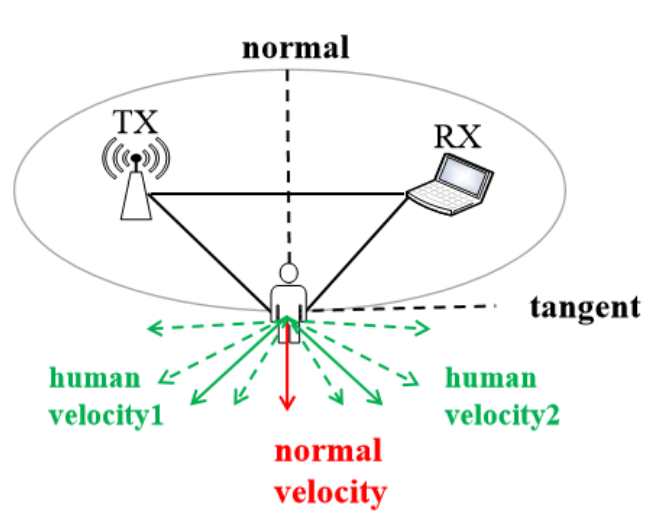
Figure 7. Directional ambiguity on symmetric velocity.